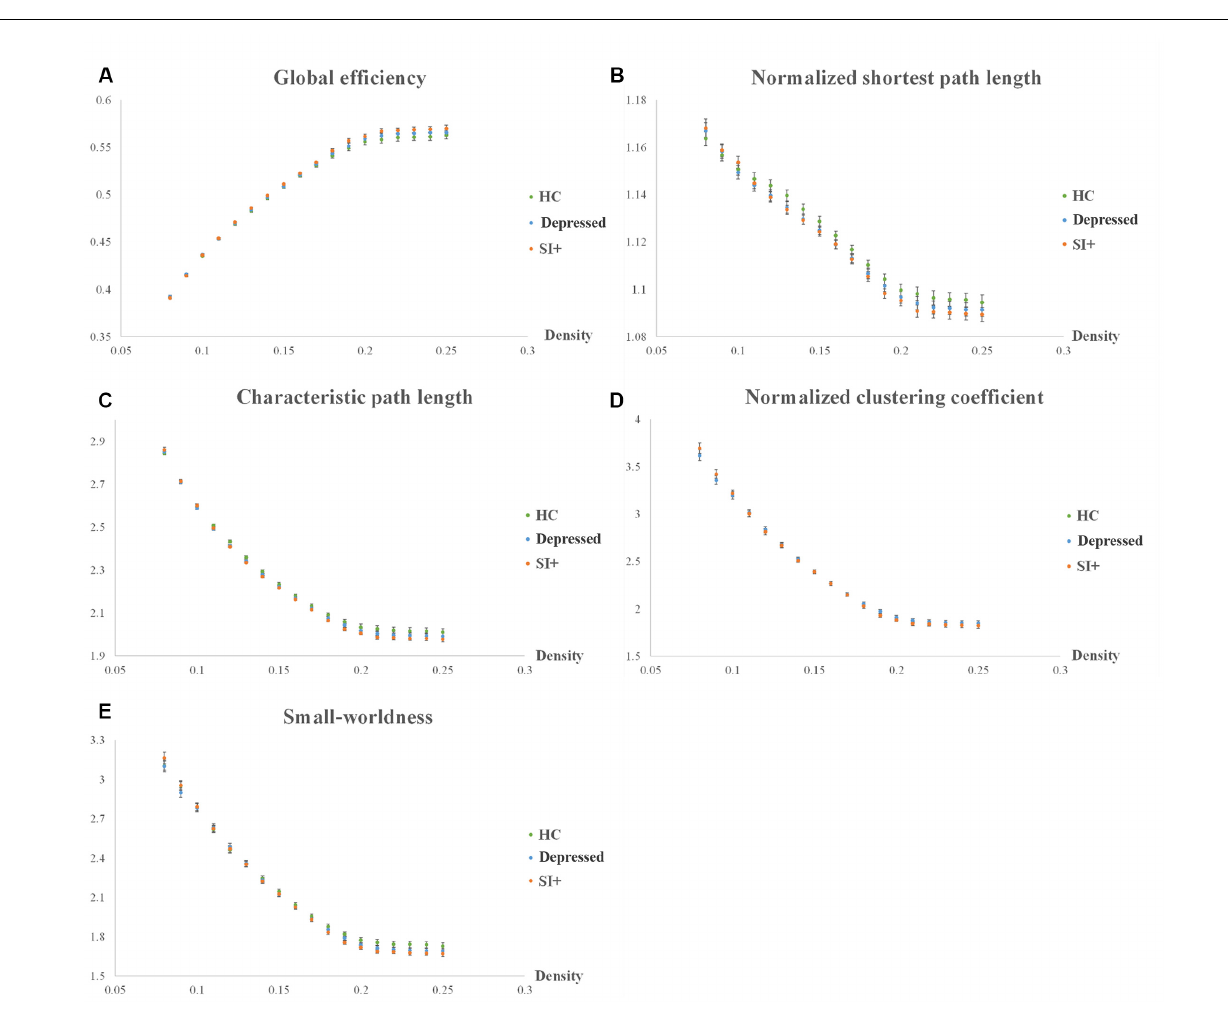
Frontiers in Human Neuroscience | www.frontiersin.org